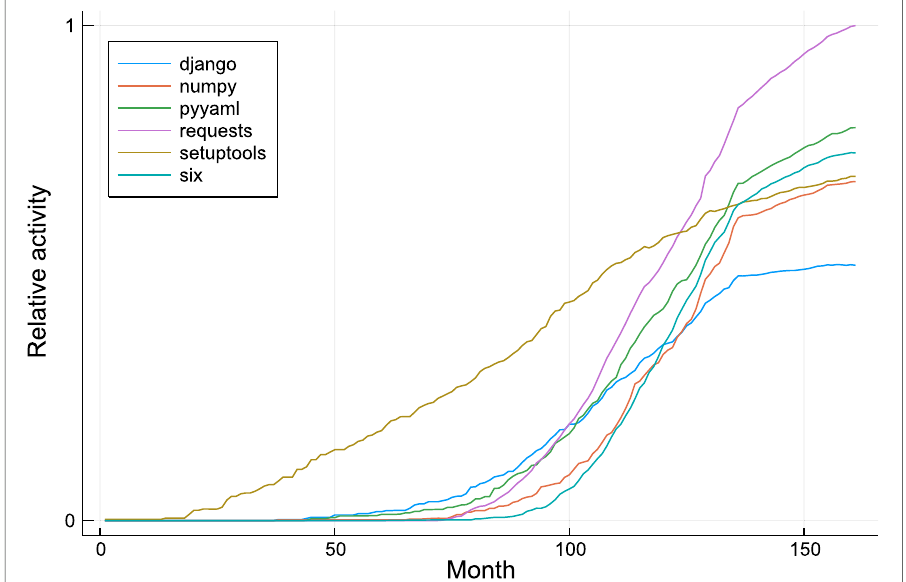
Fig. 14 npm community activity. Relative activity of each community in each month. The communities are named by important packages as detailed in the “Methods”